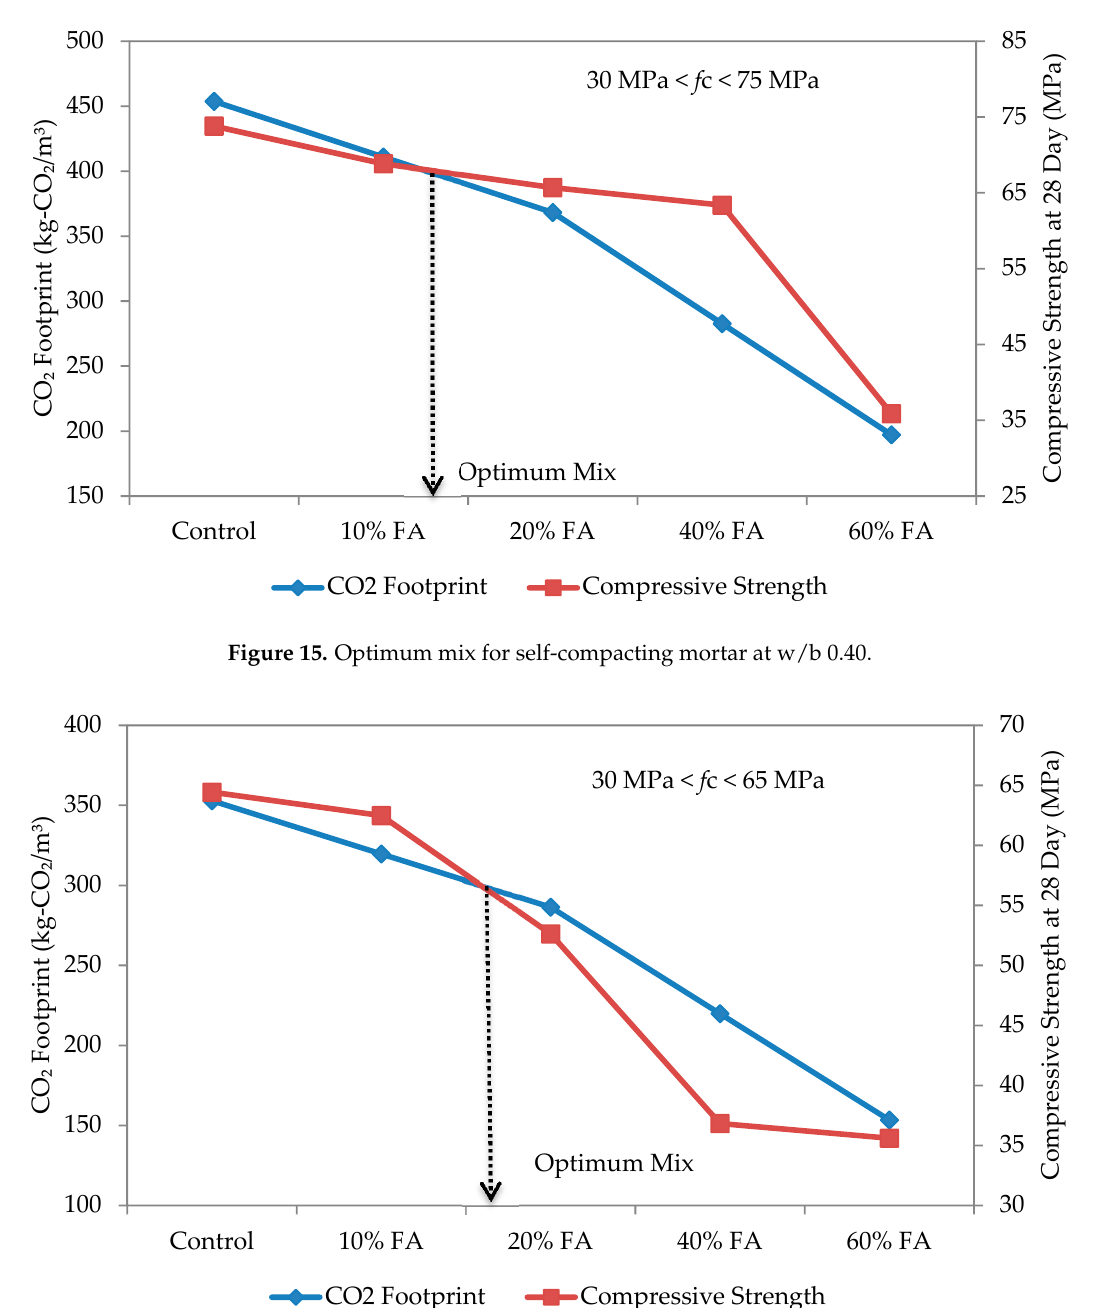
Figure 14. Optimum mix for self-compacting mortar at w/b 0.35.